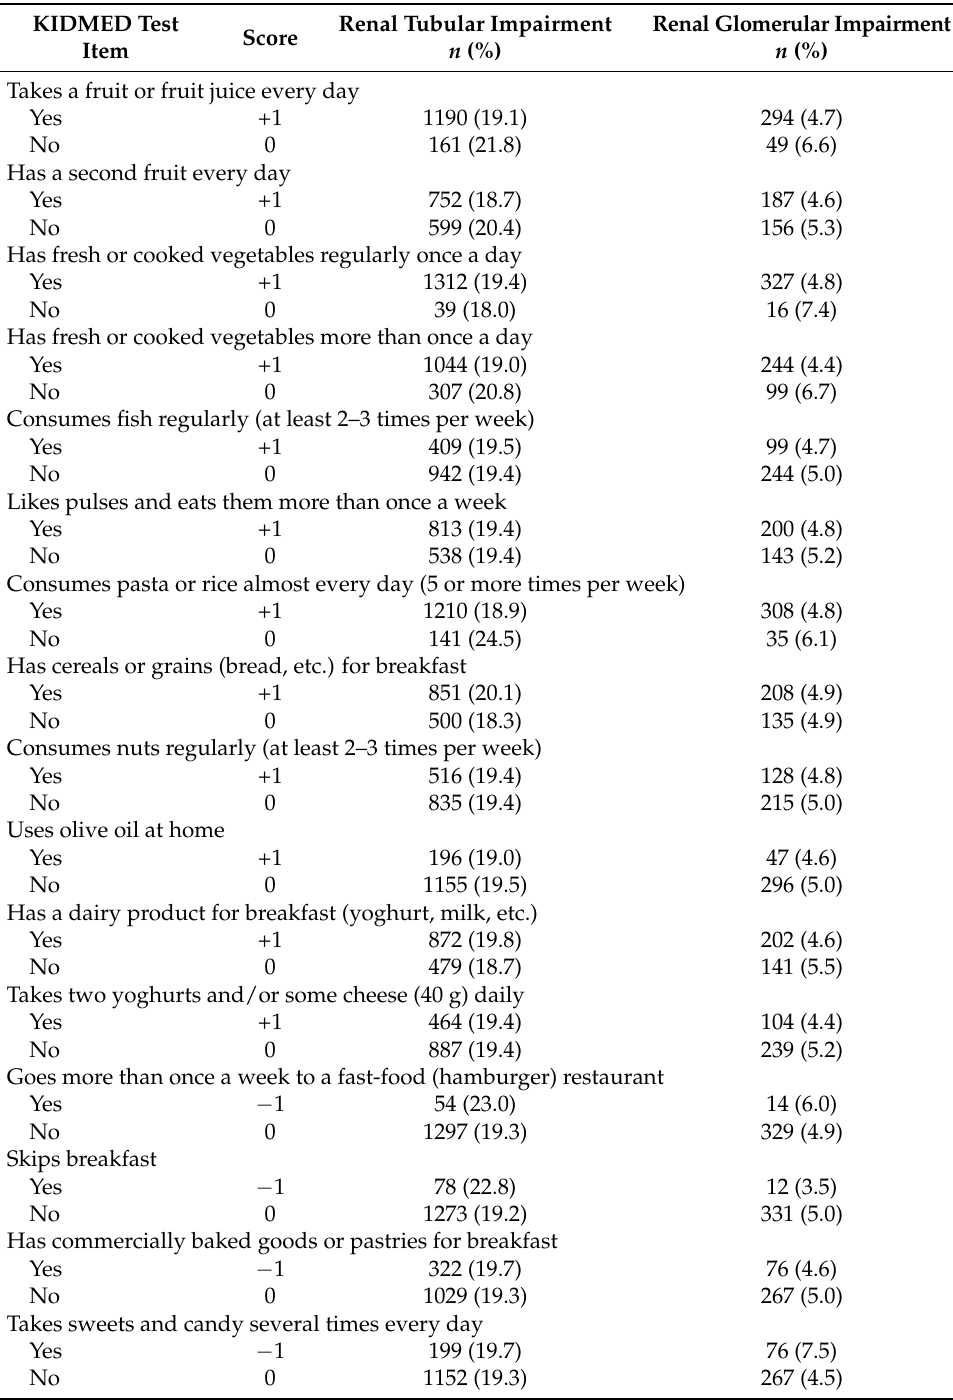
Table 4. Frequency of item-specific KIDMED test with kidney impairment (N = 6968). KIDMED